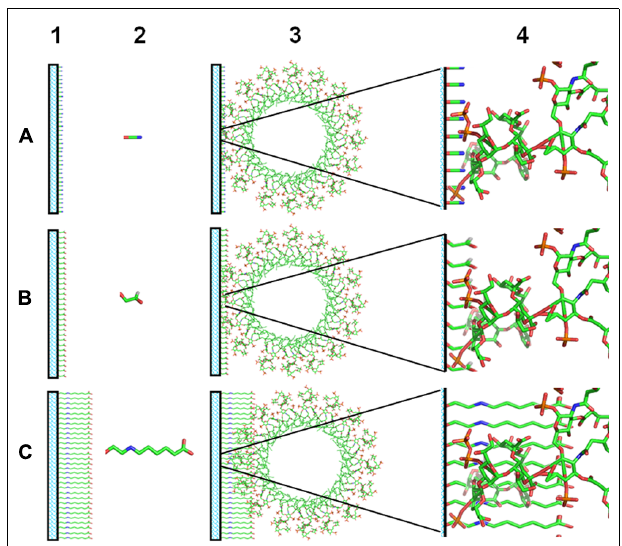
FIGURE 1 | Scheme of LPS immobilization on affinity supports. (1) Activated supports. (2) Coupling reagents. (3) Miscellar lipid A immobilized on affinity supports. (4) Zoom of the interaction of lipid A with the activated supports. (A) Cyanogen bromide activated support. (B) Glyoxyl activated support. (C) Ethyloxy-6-aminocaproic acid activated